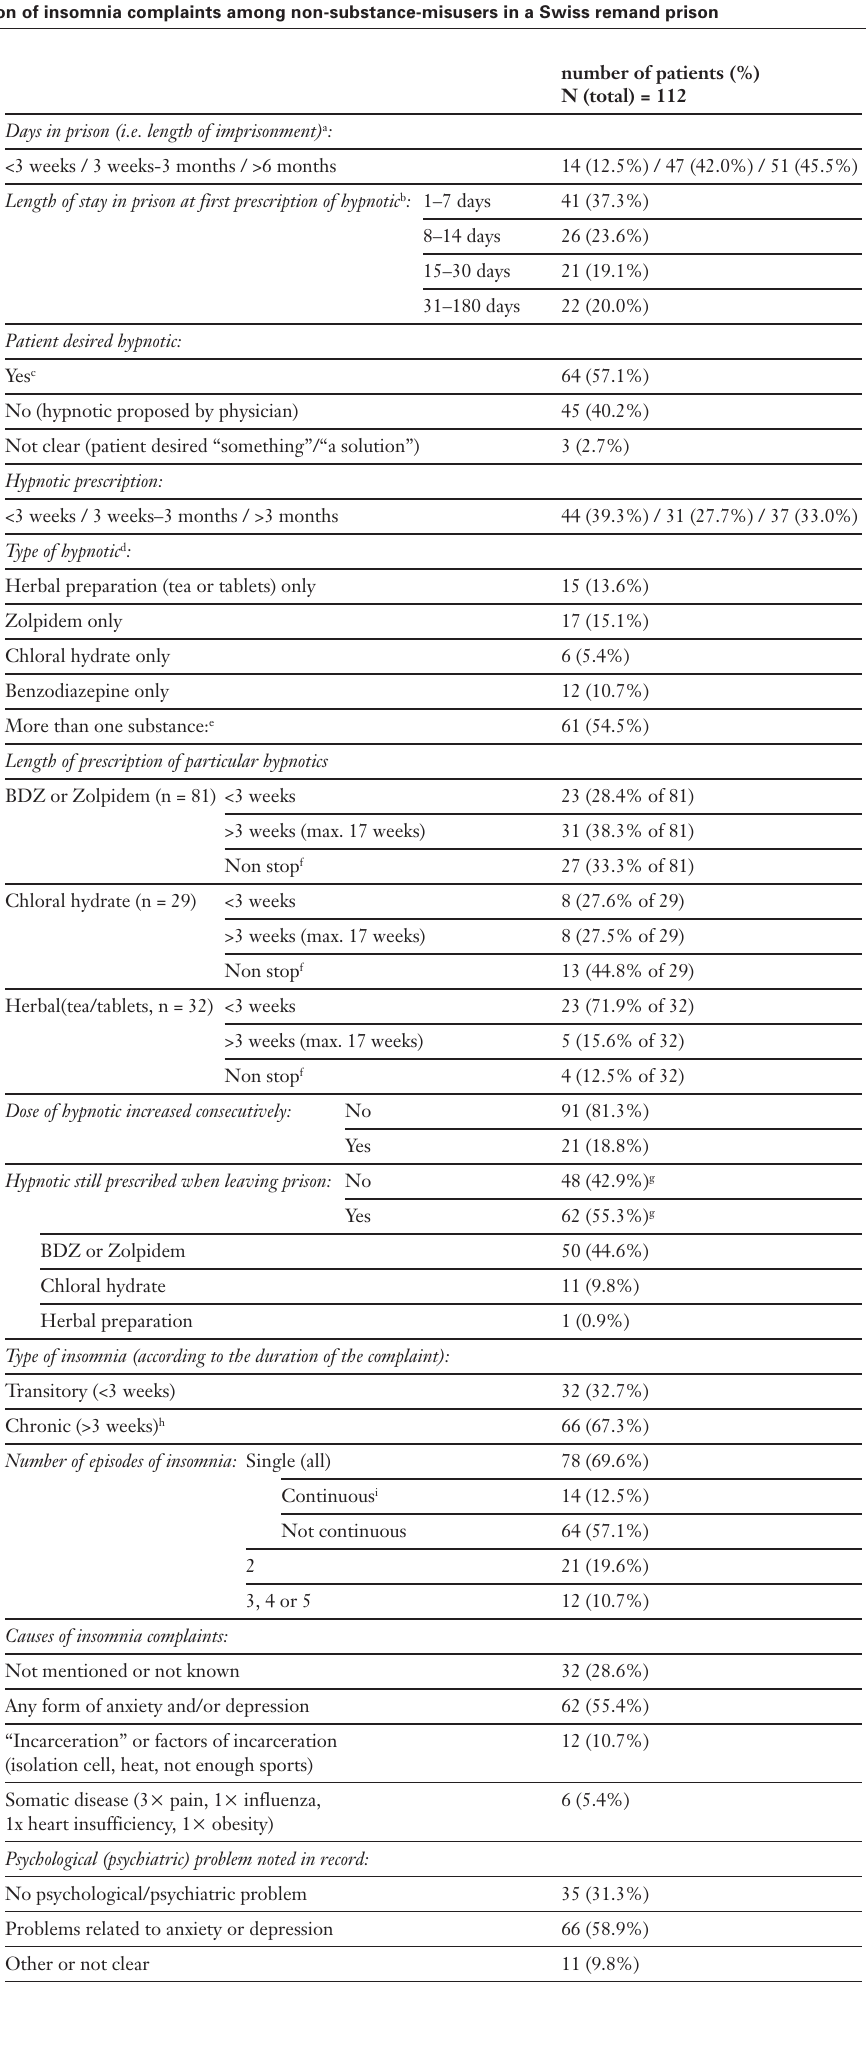
Characteristics of the 112 (101 men and 11 women) non- substance-misusing prisoners who com- plained of or have been treated for insomnia, patterns of insomnia and use of